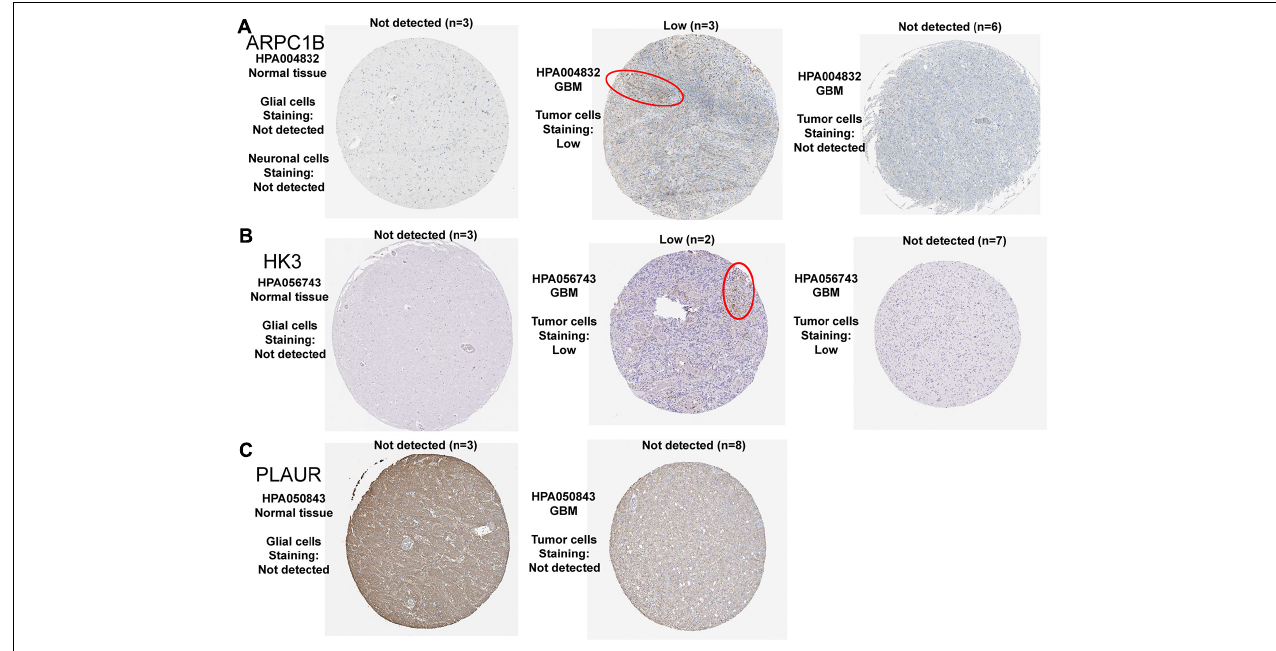
FIGURE 4 | Representative IHC images of three prognosis-related antigens in normal brain tissues and GBM tissues. (A) ARPC1B, (B) HK3, and (C) PLAUR.